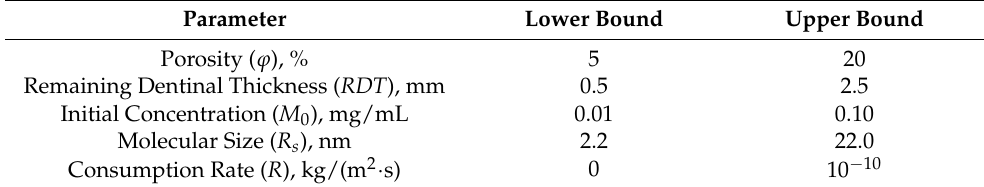
Table 1. Constraints of the design